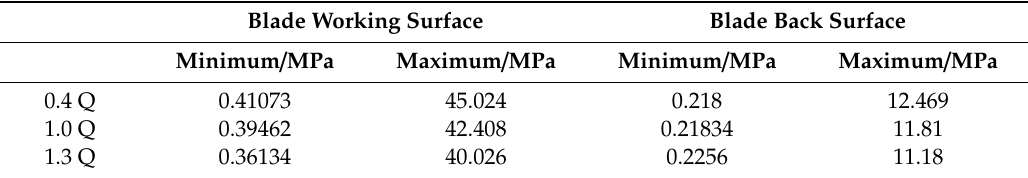
Table 5. Corresponding stress data of blade when impeller fluid-solid heat coupling at 500 °C. Blade Working Surface Blade Back Surface Minimum / MPa Maximum / MPa